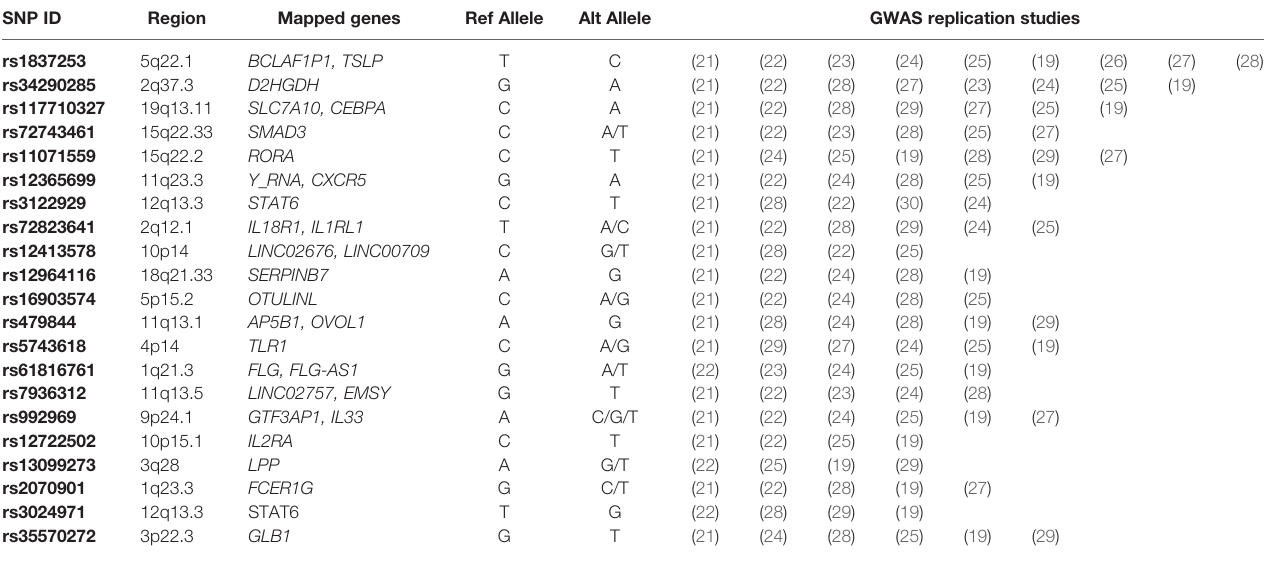
TABLE 1 | Asthma Associated SNPs replicated in GWAS from July 2018 to November 2021.